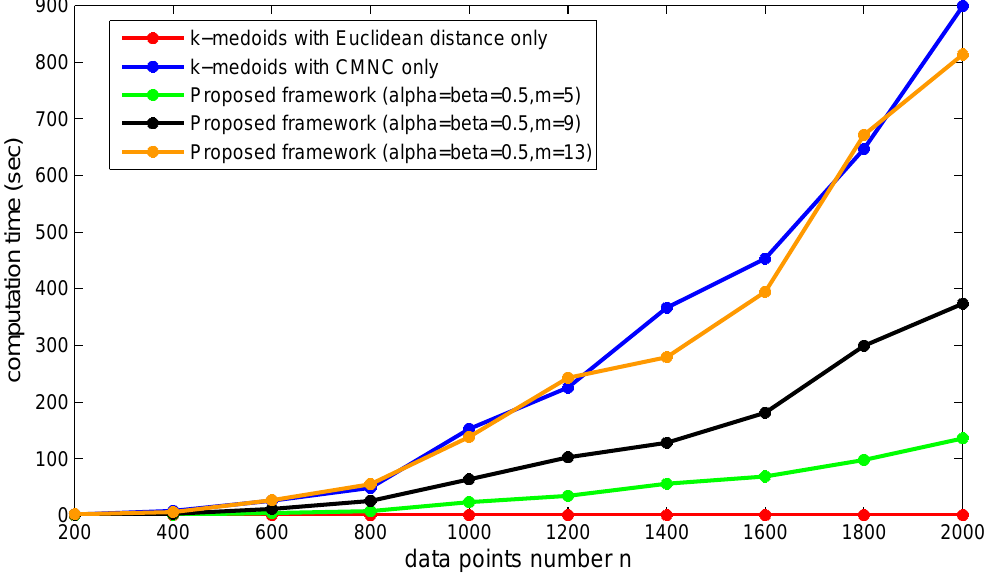
Figure 25. Increase of execution time when m